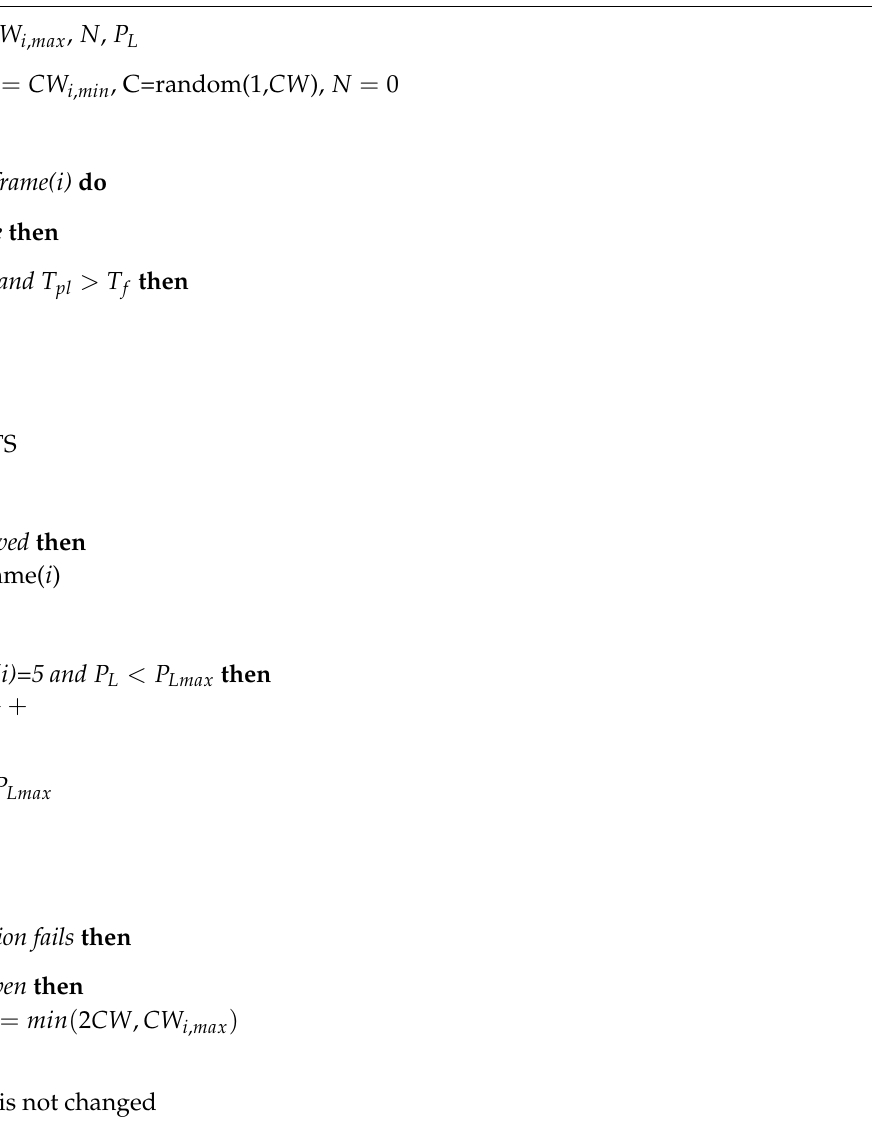
Algorithm 1 Proposed RTS/CTS scheme with power level adjustment for IEEE 802.15.6 CSMA/CA protocol.